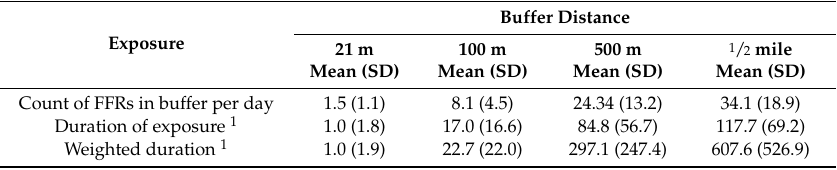
Table 2. Means (SD) of daily FFR exposure by proximity